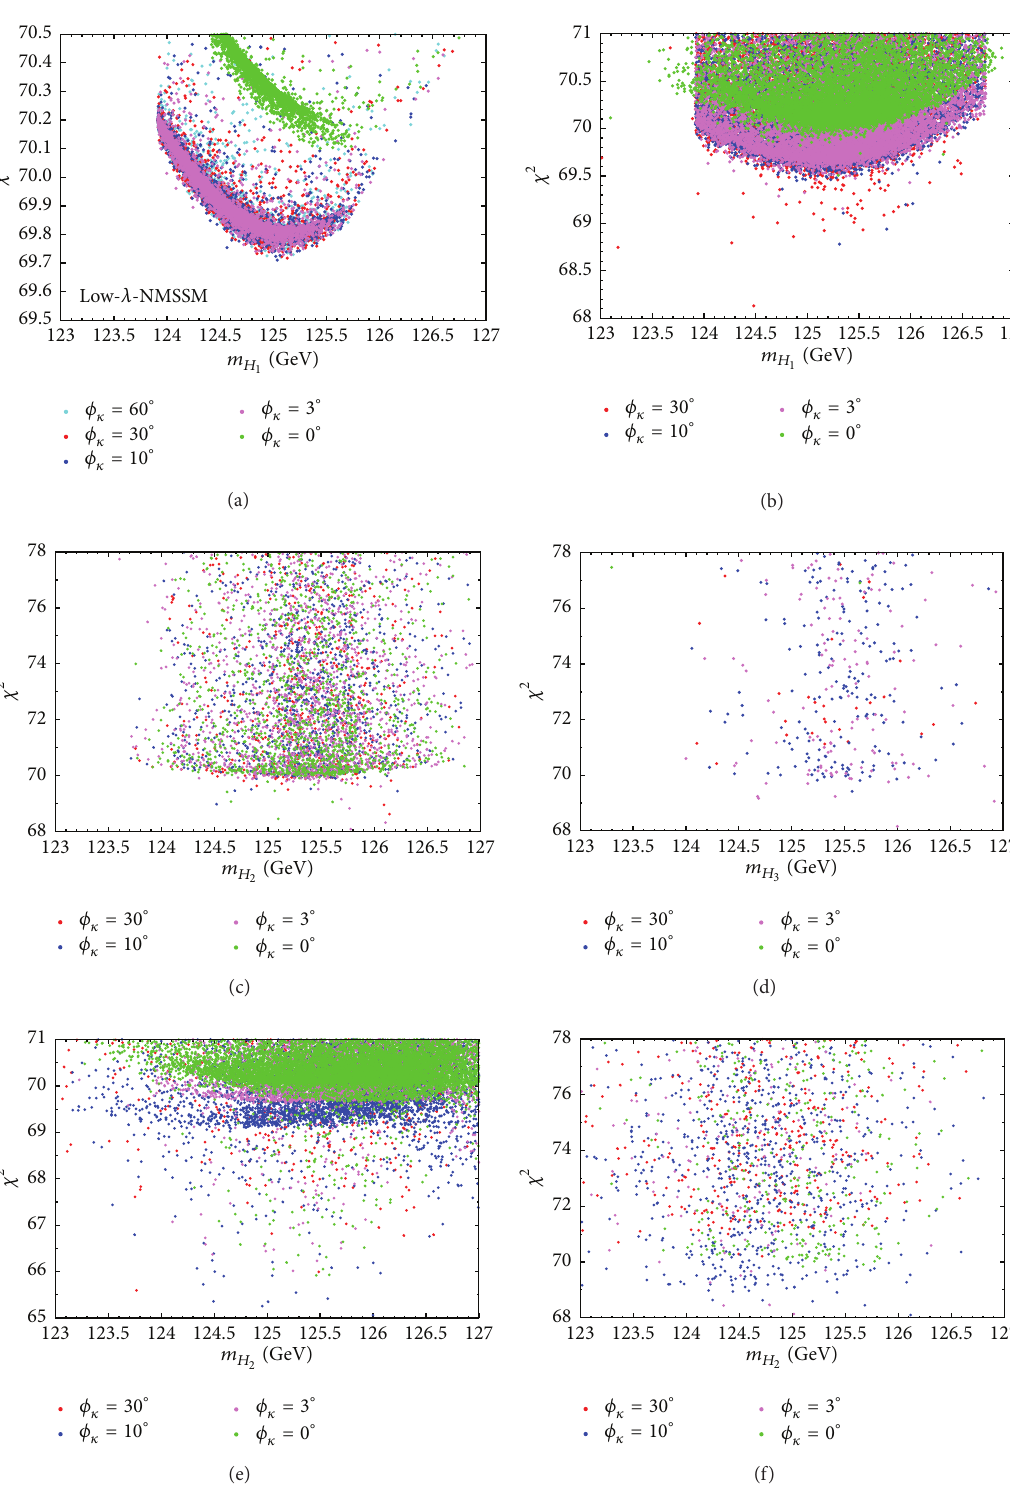
when only 𝐻 1 is assumed to be 𝐻 obs , for two different sets of scanned ranges 1 when only 𝐻 2 is the 𝐻 obs ; (d) 𝑚 𝐻 when only 𝐻 3 is 𝐻 obs ; (e) 𝑚 𝐻 2 3 when both 𝐻 2 and 𝐻 3 lie near 125 2